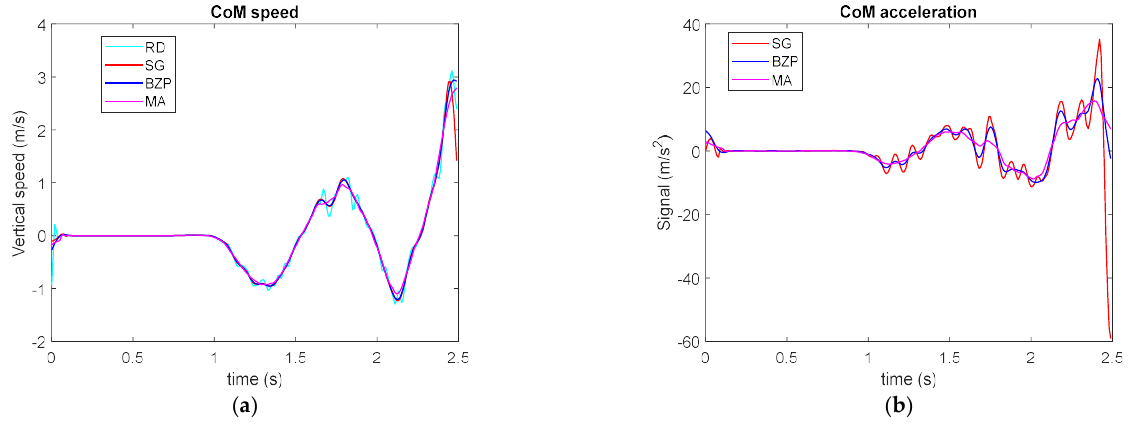
Figure 12. CoM vertical speed ( a ) and acceleration ( b ) in a maximum height jump.